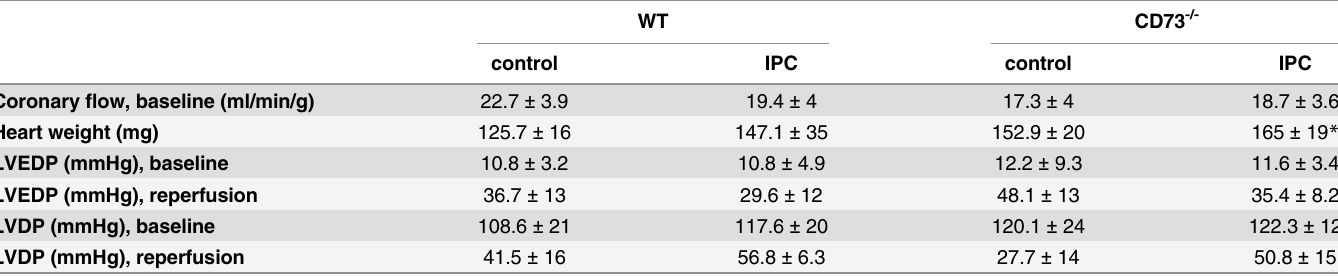
Table 1. Functional parameters of isolated perfused hearts.